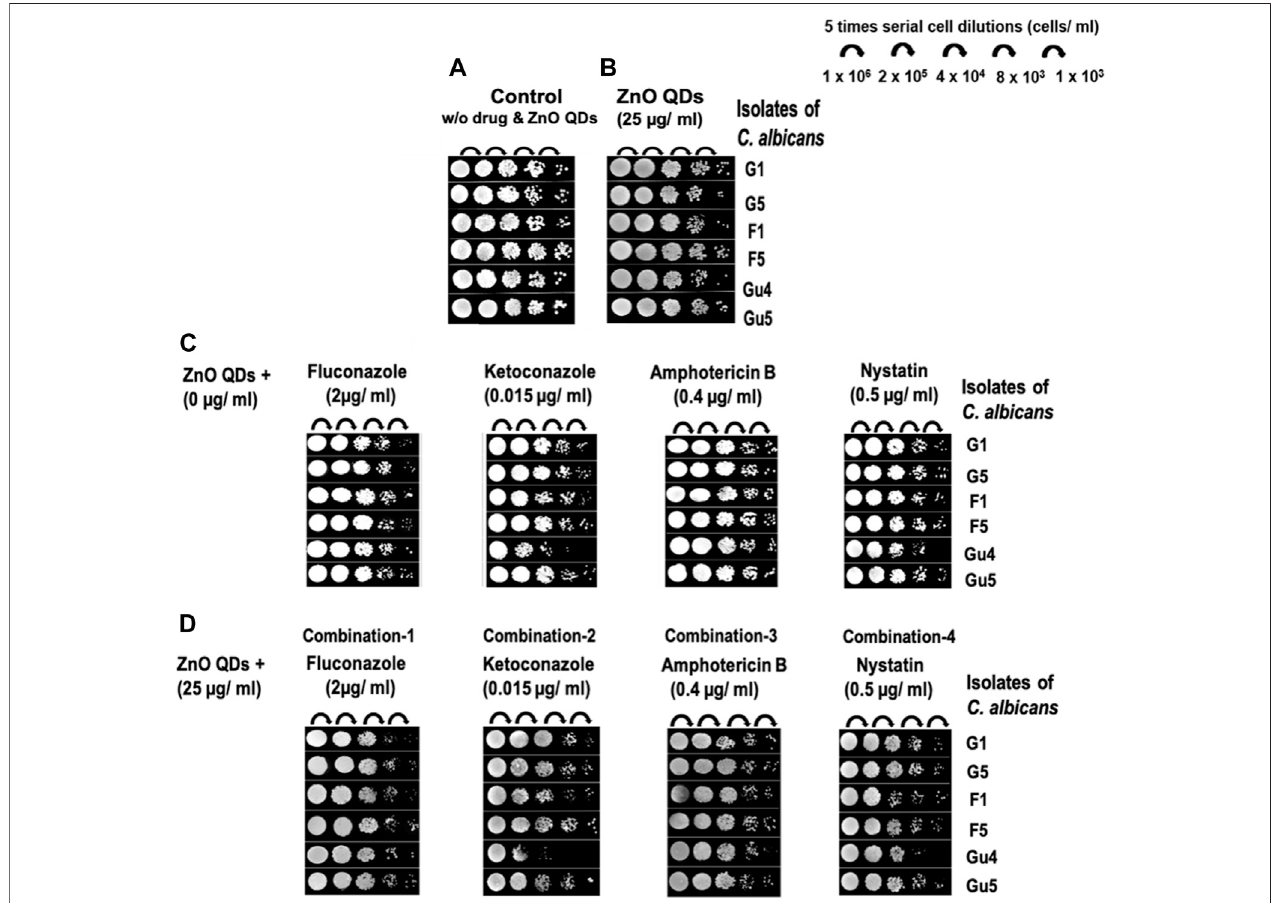
FIGURE5| Spotassayfor C.albicans clinicalisolates(G1andG5,F1andF5,andGU4andGU5)inthepresenceof: (A) Growthcontrol(absenceofbothZnOQDs and drugs); (B) ZnO QDs (25 µg/ml) only; (C) drug alone: fl uconazole (2 µg/ml), ketoconazole (0.015 µg/ml), amphotericin B (0.4 µg/ml), and nystatin (0.5 µg/ml); (D) different combinations containing both ZnO QDs (25 µg/ml) and antifungal drugs [( fl uconazole (2 µg/ml) or ketoconazole (0.015 µg/ml) or amphotericin B (0.4 µg/ml) or nystatin (0.5 µg/ml)].